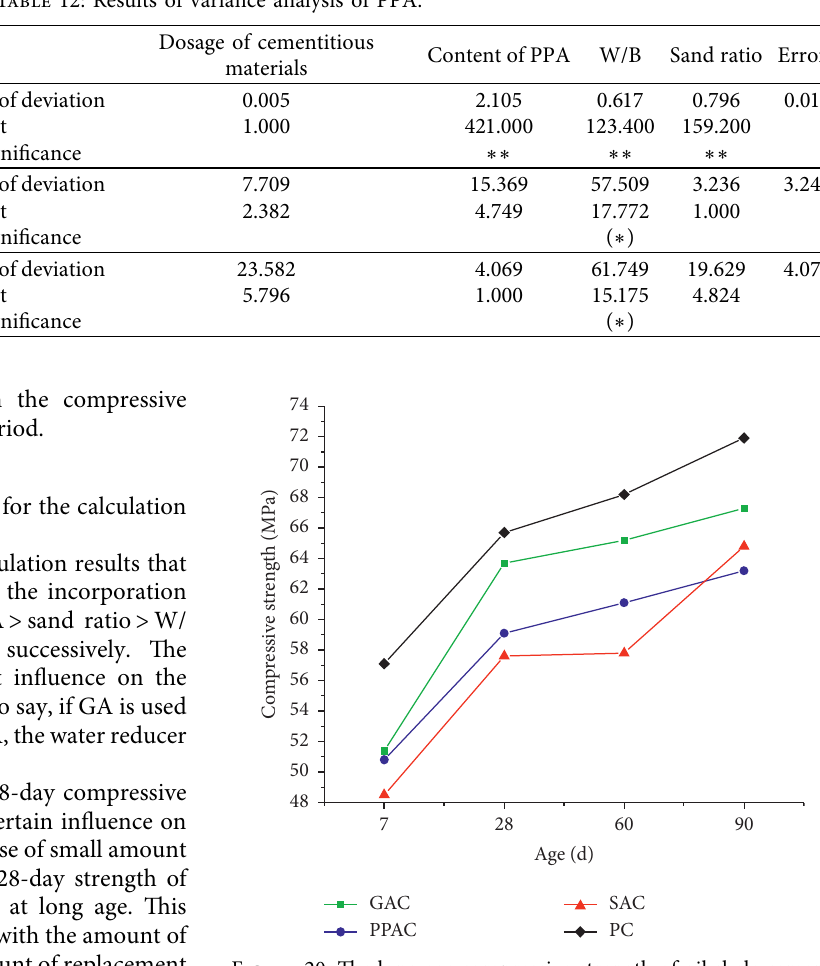
Table 12: Results of variance analysis of PPA.